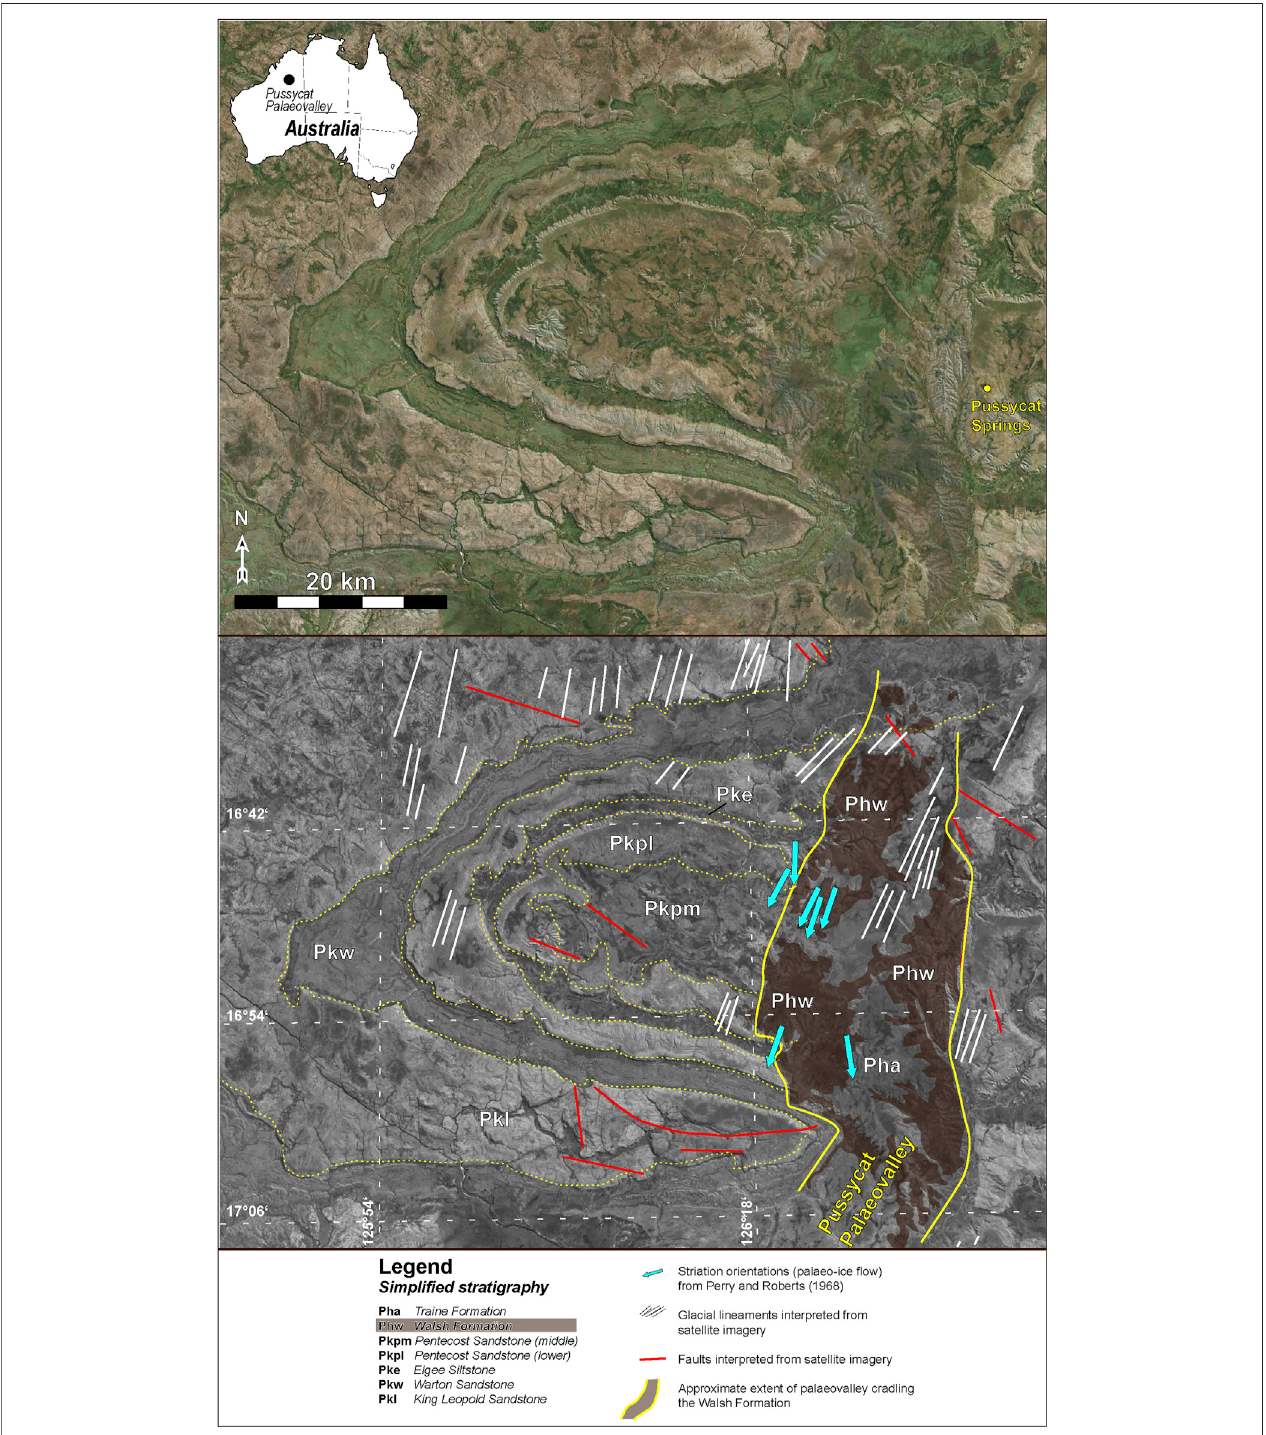
FIGURE 2 | A newly discovered Cryogenian glaciated land surface in Australia. Bing Maps image with corresponding interpretation showing a zone to the west of PussycatSprings,Kimberley,WesternAustraliaoffoldedMesoproterozoicstrataoverlainbytheWalshFormation (aCryogenian diamictite). Interpretation ofthisancient land surface shows the location and orientation of measured striated pavements with ice fl ow directions indicated (data from Perry and Roberts, 1968), together with interpreted lineaments of probable glaciogenic origins observed on the satellite imagery. The latter cross cut many units underneath the Walsh Formation. The geometry of the Walsh Formation outcrop is notably con fi ned to a belt of N-S oriented strata, which we herein interpret as a possible palaeovalley (the Pussycat Palaeovalley). Non-glacial lineaments (faults) are distinguished also.